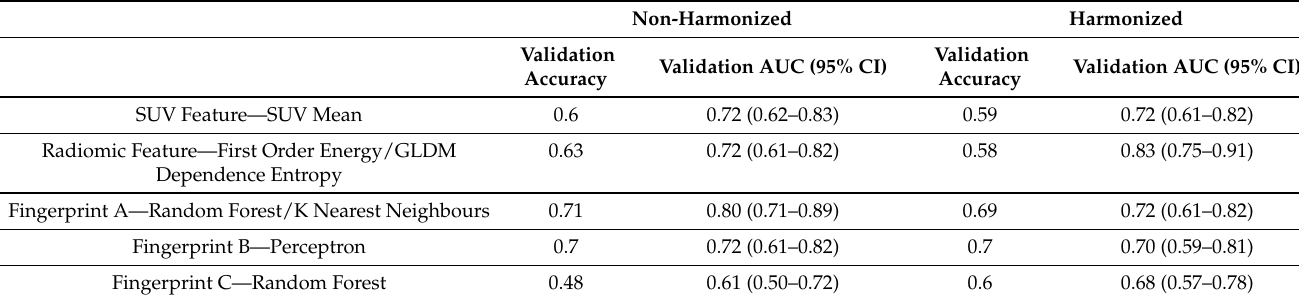
Table 8. The diagnostic utility of the explored methods when data with an altered imaging acquisition protocol is